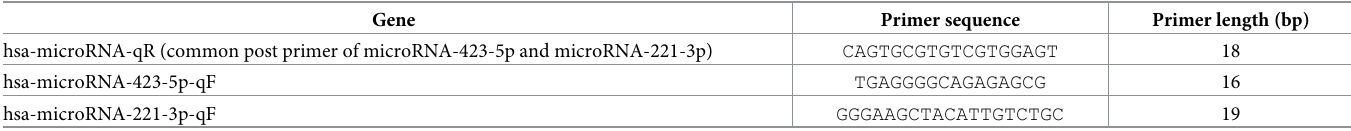
Table 2. The primers and sequences for detecting genes by